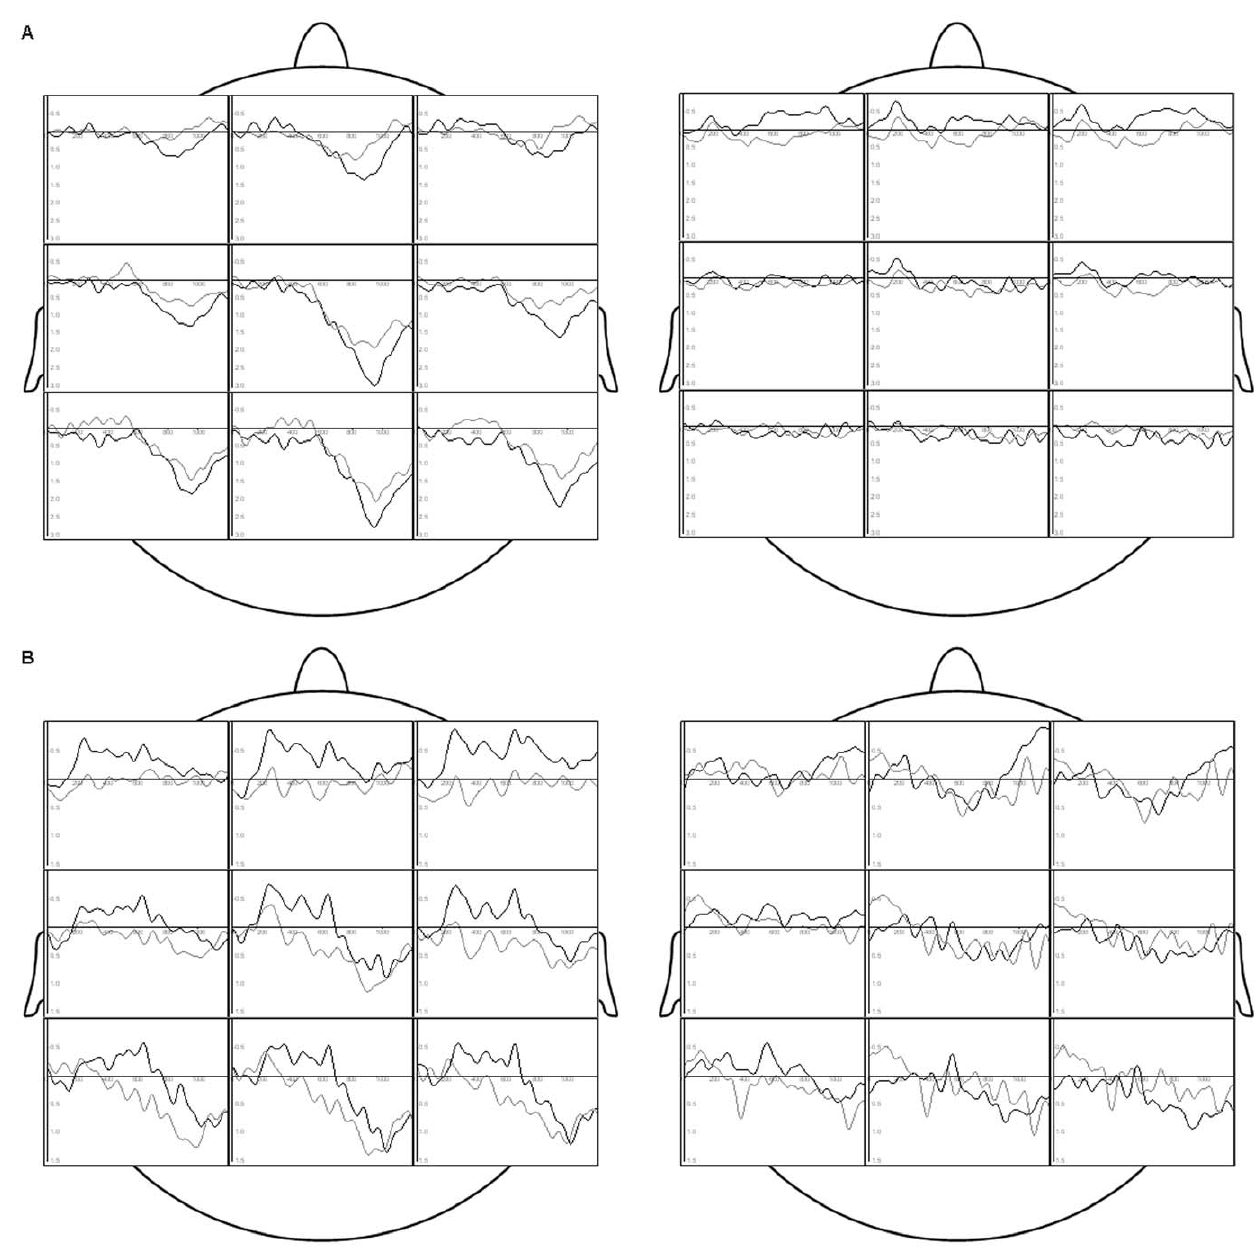
Figure 1. Grand Averages. (A) Grand Averages of the CSERPs of non-socially anxious female (left; N=12, 24 sessions) and male (right; N=16, 32 sessions) participants in response to sweat donated during the anxiety condition (black line) and the sport control condition (grey line) at pooled electrode positions (anterior left, anterior midline, anterior right, central left, central midline, central right, posterior left, posterior midline, posterior right). (B) Grand Averages of the CSERPs of socially anxious female (left; N=8, 16 sessions) and male (right; N=8, 16 sessions) participants in response to sweat donated during the anxiety condition (black line) and the sport control condition (grey line) at pooled electrode positions (see Fig. 1A).